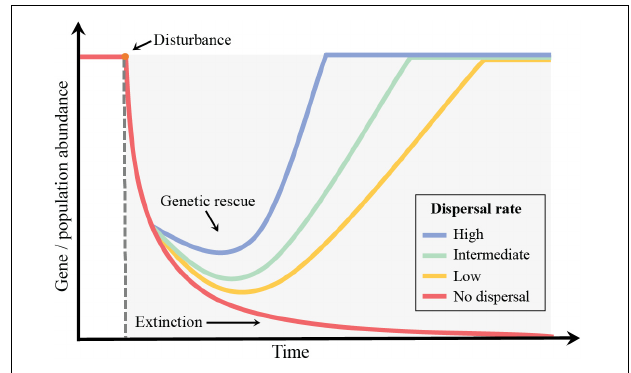
FIGURE 4 | Conceptual model displaying the potential decay in gene abundance due to population decline after disturbance. Dispersal contributes to genetic rescue and avoids loss of genetic variation. Different dispersal rates relate to the pace of genetic rescue over time.